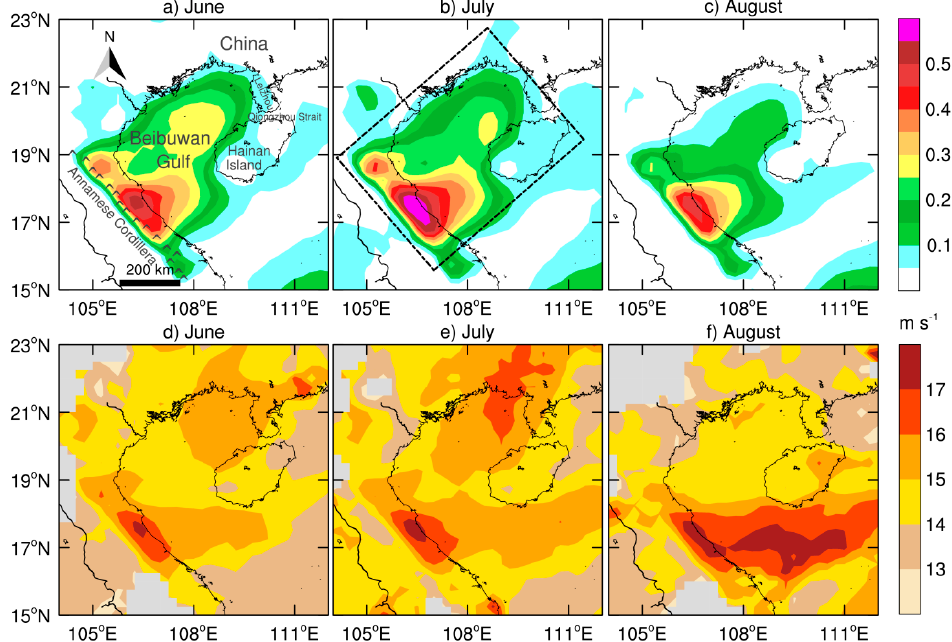
Figure 2. Horizontal distribution of the occurrence rate of LLJs in ( a ) June, ( b ) July, and ( c ) August and the maximum wind speed of LLJs in ( d ) June, ( e ) July, and ( f ) August averaged from 2015 to 2019 over the Beibuwan Gulf (BBG), South China